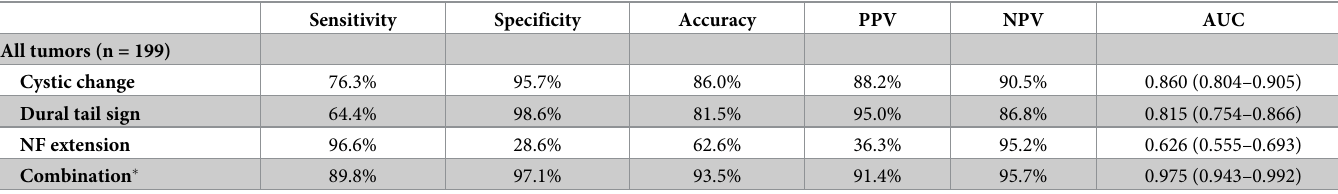
Table 2. Diagnostic performances of the MRI